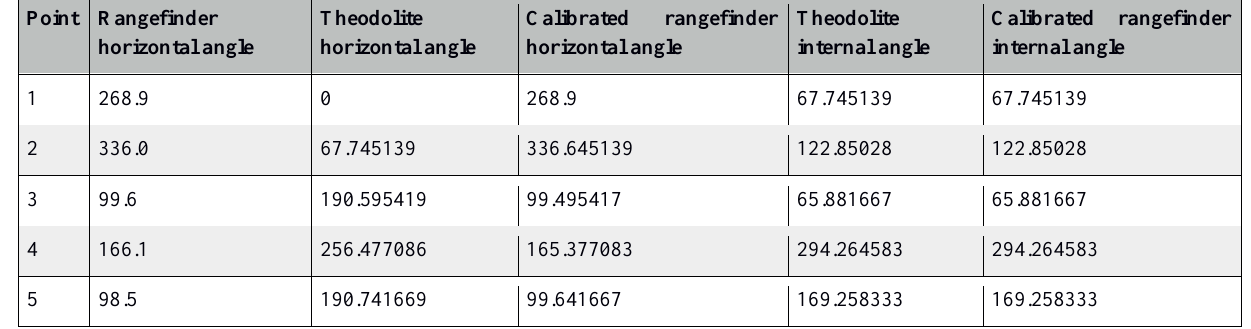
Table 4: Calibration of room 10 rangefinder horizontal angle measurements by homotopies (in decimal degrees). Point Horizontal